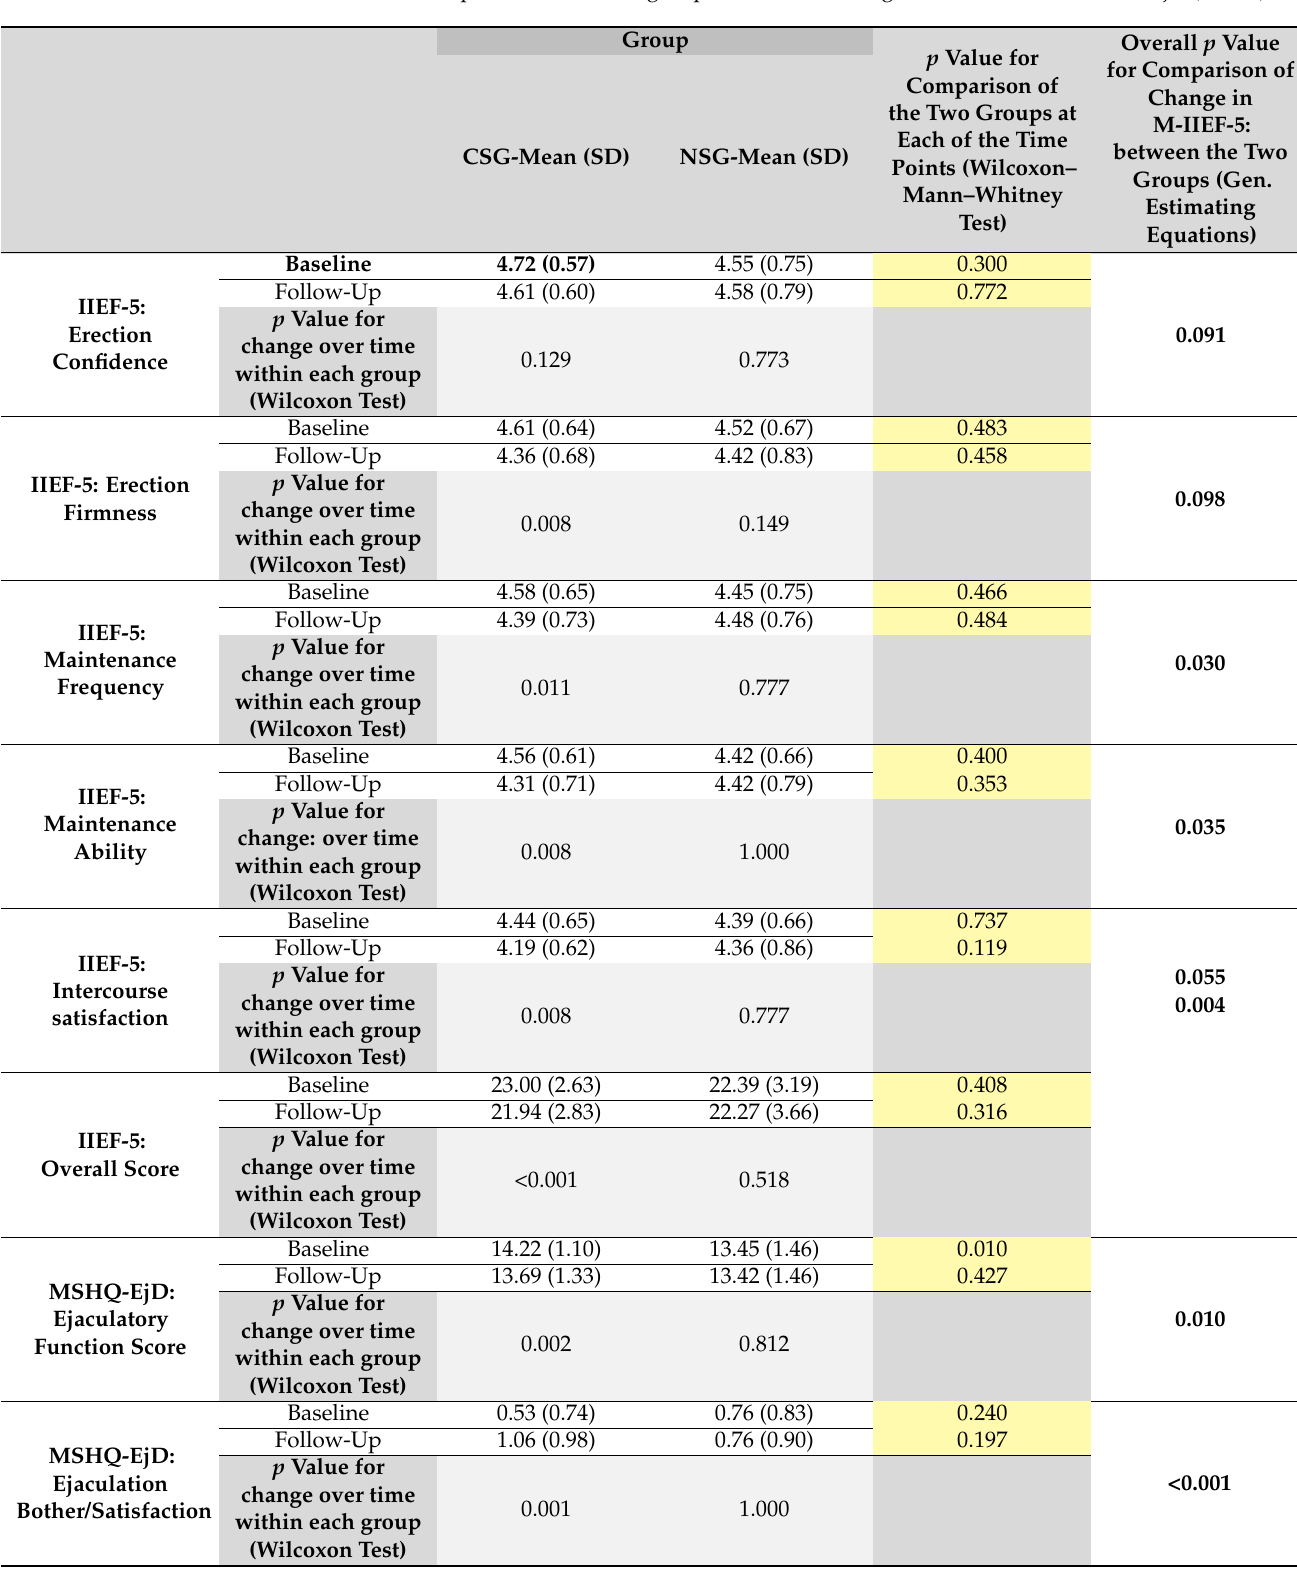
Table 2. Comparison of the two groups in terms of change in M-IIEF-5 and MSHQ-EjD (n = 69). Group CSG-Mean (SD) NSG-Mean (SD)